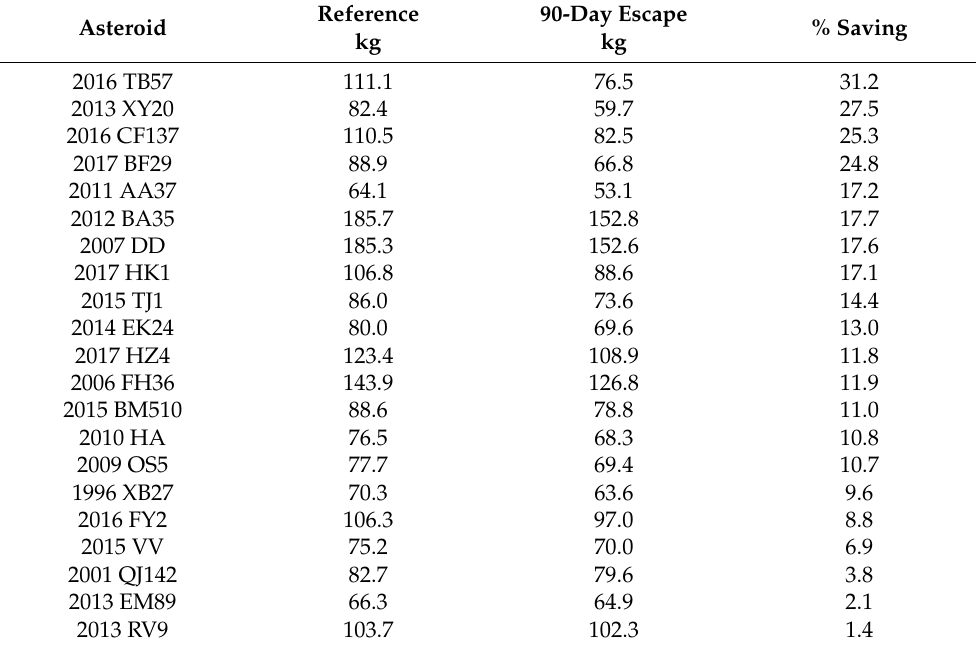
Table 8. SEL2 escapes—asteroid rendezvous propellant mass